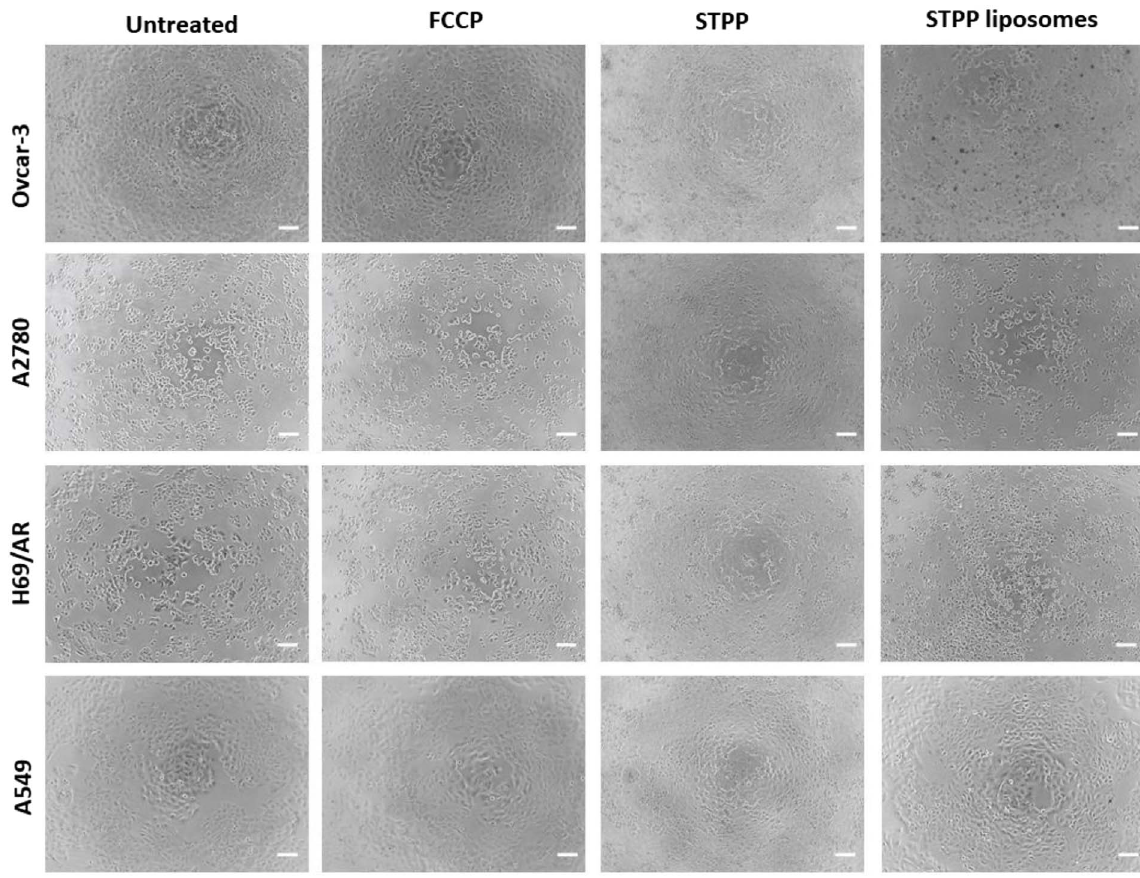
Figure 5. Qualitative determination of STPP and FCCP toxicity human ovarian carcinoma and human lung carcinoma cells. Light micrographs of indicated cell lines with no treatment (untreated) 100 l M FCCP in DMSO for 4 h (FCCP), 80 l M STPP in DMSO for 5 h (STPP) and 80 l M STPP liposomes for 5 h (STPP liposomes). Scale bar indicates 100 l